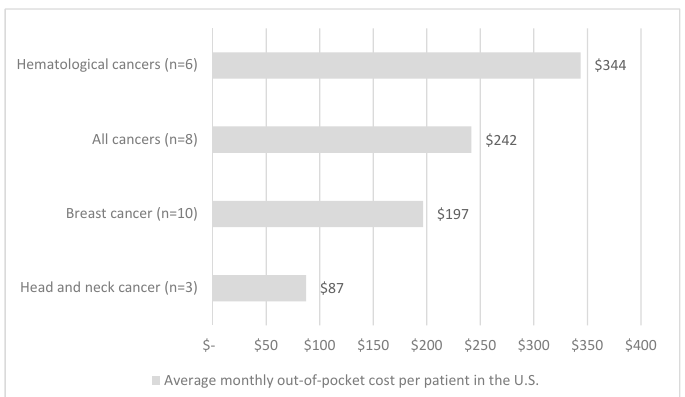
Figure 5. Average monthly out-of-pocket costs per patient by cancer site in the U.S. Note: Studies that included patients with multiple cancer sites are reported under the ‘All cancer’ category. Costs are expressed in 2018 USD. Not enough data were available to report average costs per can- cer site for low- and middle-income countries, or for other high-income countries. We reported and estimated the total out-of-pocket costs as a proportion of the annual income in 33 studies (Table 2). Figure 6 summarizes these estimates per study and country income-level and presents a weighted average for HICs (U.S., Canada, Australia) and LMICs (China, Malaysia, India, Haiti, Brunei, Thailand, Indonesia, Philippines, Vietnam, Laos, Cambodia, Myanmar). Cancer patients and caregivers in HICs spent, on average, 16% of their annual income on out-of-pocket expenses related to cancer care, compared with 42% among LMICs. Most studies conducted in LMICs reported a mean estimate above 30%, and although most studies conducted in HICs were distributed in the lower end, 40% reported an annual expenditure of over 20% of the annual income. A study con- ducted in Canada among breast cancer patients estimated the lowest proportion of income spent as out-of-pocket costs at 2.3% [90]. At the other extreme, a study of pediatric cancer patients in India estimated that caregivers incurred considerable debt and spent over 175% of their annual income as medical and non-medical out-of-pocket costs [59]. How- ever, this study had a small sample size and contributed relatively little to the estimated 42% weighted average income spent as out-of-pocket expenses in LMICs. Additionally, four studies defined explicit thresholds for catastrophic health expenditure [27,68,69,101]. They defined a threshold of annual income spent as out-of-pocket expenditures and esti- mated the proportion of patients exceeding it. In two studies, CHE was defined as 30% of the annual household income spent as non-reimbursed out-of-pocket costs in two studies conducted in different LMICs of South East Asia among an all cancer population [68,69]. This threshold was also defined at 40% in Haiti among breast cancer patients [101] and 10% in India among patients with pancreatic cancer [27]. The proportion of patients in- curring CHE, however defined, ranged between 31% and 67%.